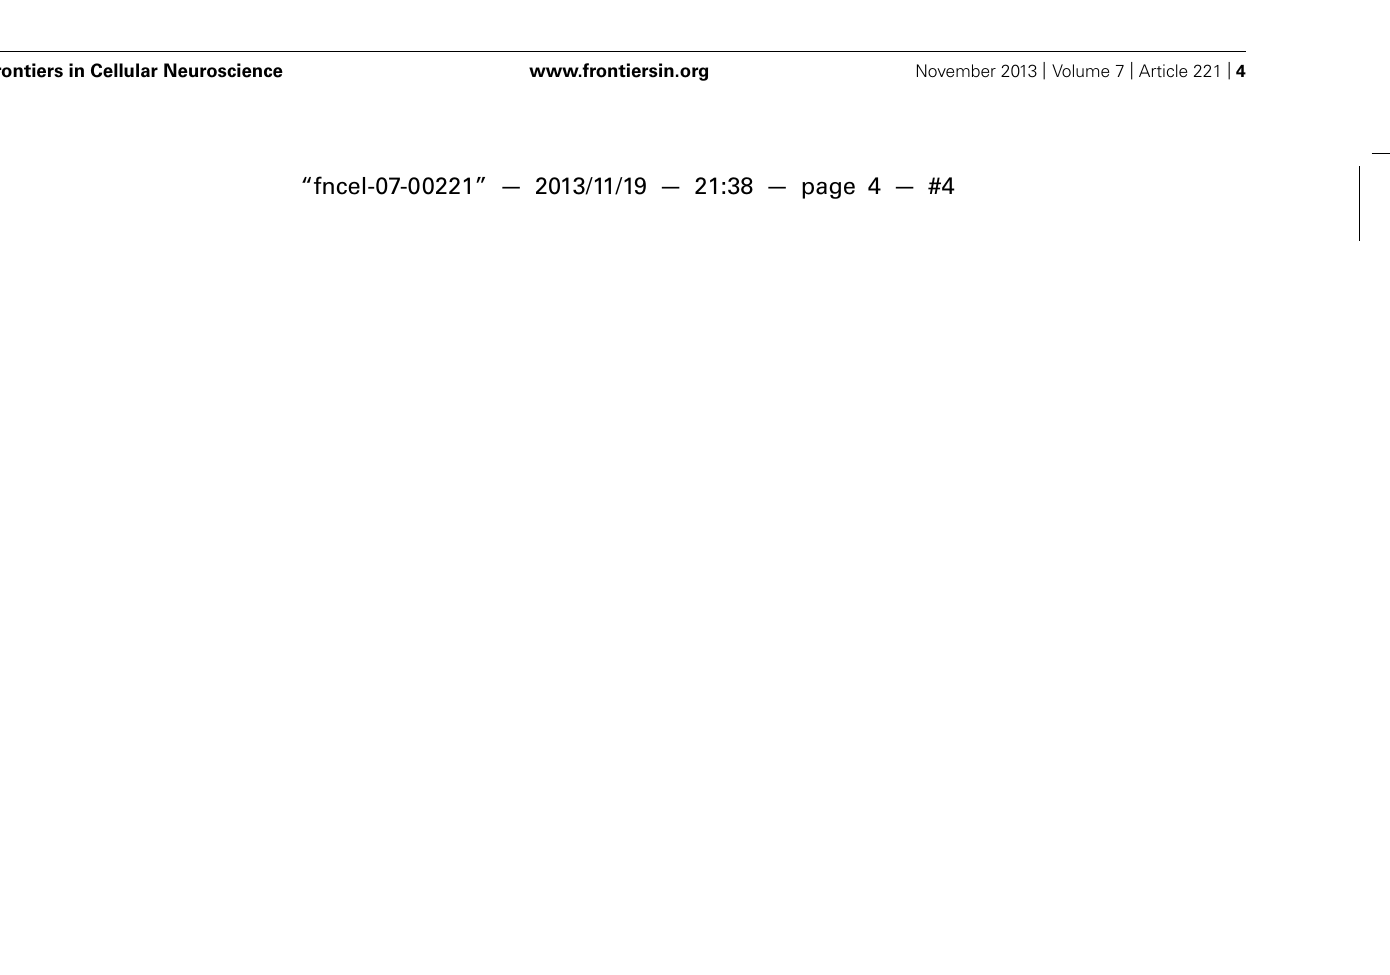
FIGURE 2 |Tangential migration of neocortical interneurons. Newborn neocortical interneurons follow two tangentially oriented migratory streams to enter the cortex: a superficially migrating early cohort (blue) migrates through the marginal zone (MZ), and a deeply migrating second and more prominent cohort (green) migrates through the lower inter- mediate zone (IZ) and subventricular zone (SVZ). Tangential migration is mediated by the coordination of several chemorepulsive (i.e., sema3A/3F expressed in striatum), permissive (i.e., NRG-CRD highly expressed in GE), and chemoattractive (i.e., NRG1-Ig expressed in cortical VZ/SVZ)